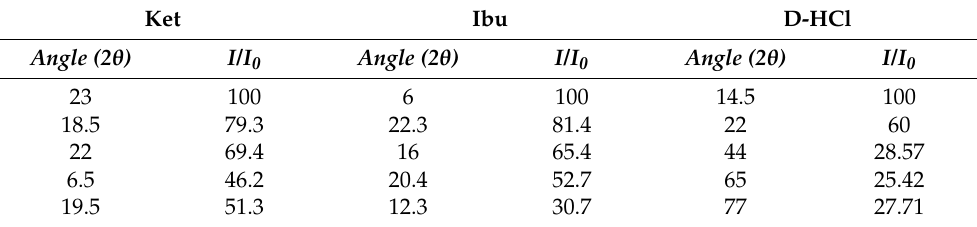
Table 4. Main XRD relative intensities for nanoparticles single components and mixtures